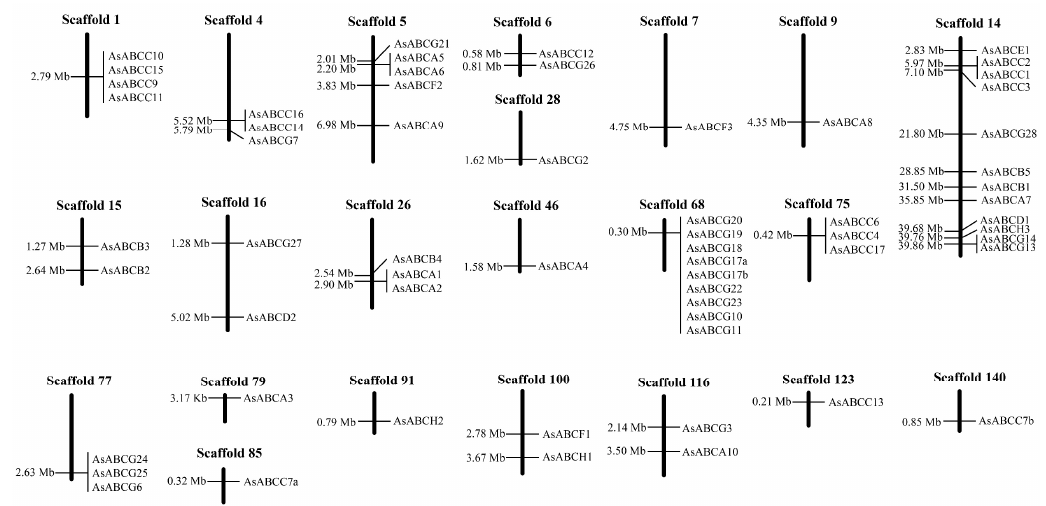
Figure 2. Distribution of A. sinensis ABC transporter genes on scaffolds. The number of left side on scaffold represents physical locations, and on the right side are gene names.